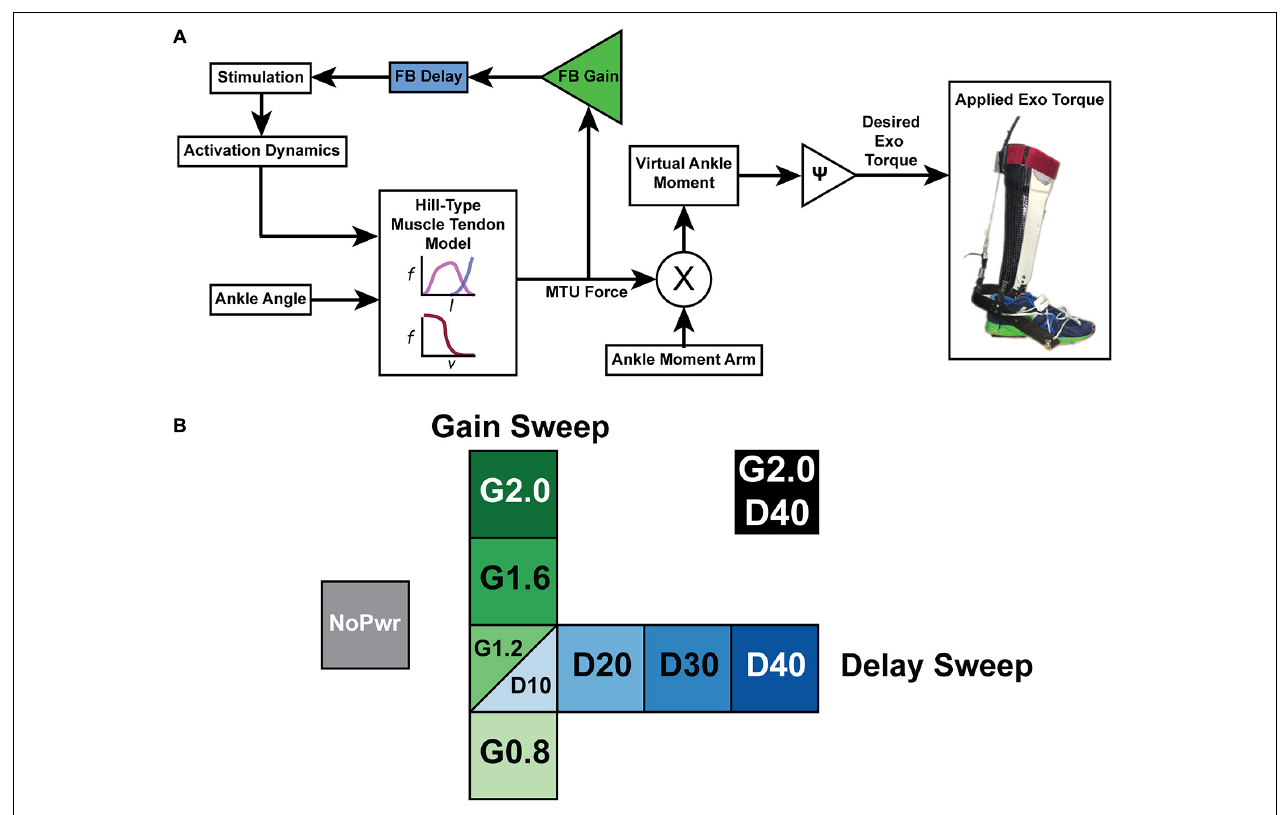
FIGURE 1 | A powered ankle exoskeleton using neuromuscular model (NMM) based control across a range of virtual reflex settings (A) Block diagram of a neuromuscular model (NMM) based controller to generate torque output of a powered ankle exoskeleton. The user’s ankle joint angle drives the length change of a virtual muscle-tendon unit (MTU) that uses a positive force feedback reflex loop to stimulate a virtual Hill-type muscle contractile element with force-length and force velocity properties similar to the human plantarflexors. The virtual muscle produces a force that is transmitted through a virtual tendon and then applied through a virtual moment arm to generate a virtual ankle moment which is scaled to produce a desired exoskeleton torque. (B) Test conditions for NMM reflex Gain and Delay parameter sweeps included an unpowered or zero-torque condition (NoPwr) (gray) along with powered ankle exoskeleton conditions using controllers with increasing virtual reflex Gain = 0.8, 1.2, 1.6, and 2.0 all with a 10 ms Delay (G0.8, G1.2, G1.6, and G2.0, respectively) (green); increasing virtual reflex Delay = 10, 20, 30, and 40 ms all with a 1.2 reflex Gain (D10, D20, D30, D40, respectively) (blue); and a high-Gain-high-Delay condition (G2.0 D40) (black). All tests were